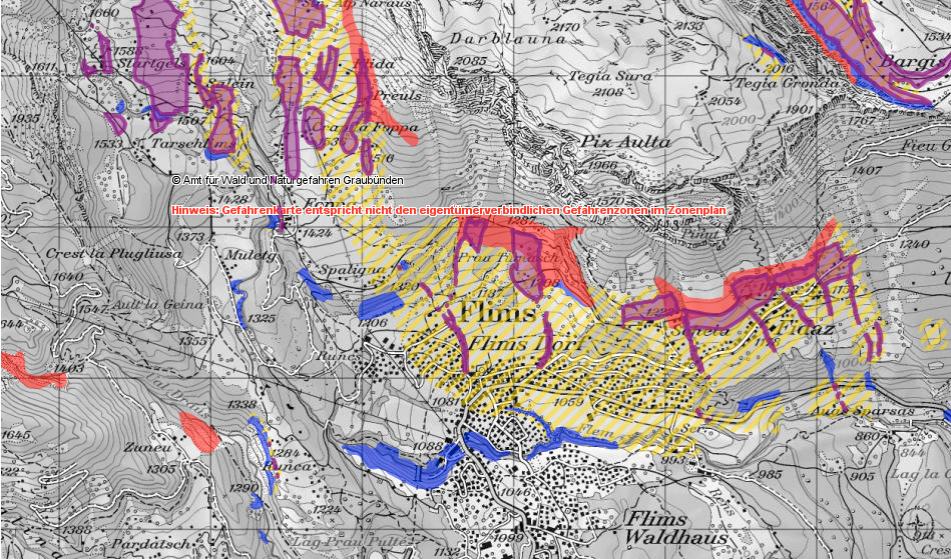
Figure 6. Natural hazard risk map of Flims: rock fall risk zones (Latitude: 46.836635 | Longitude: 9.284692).